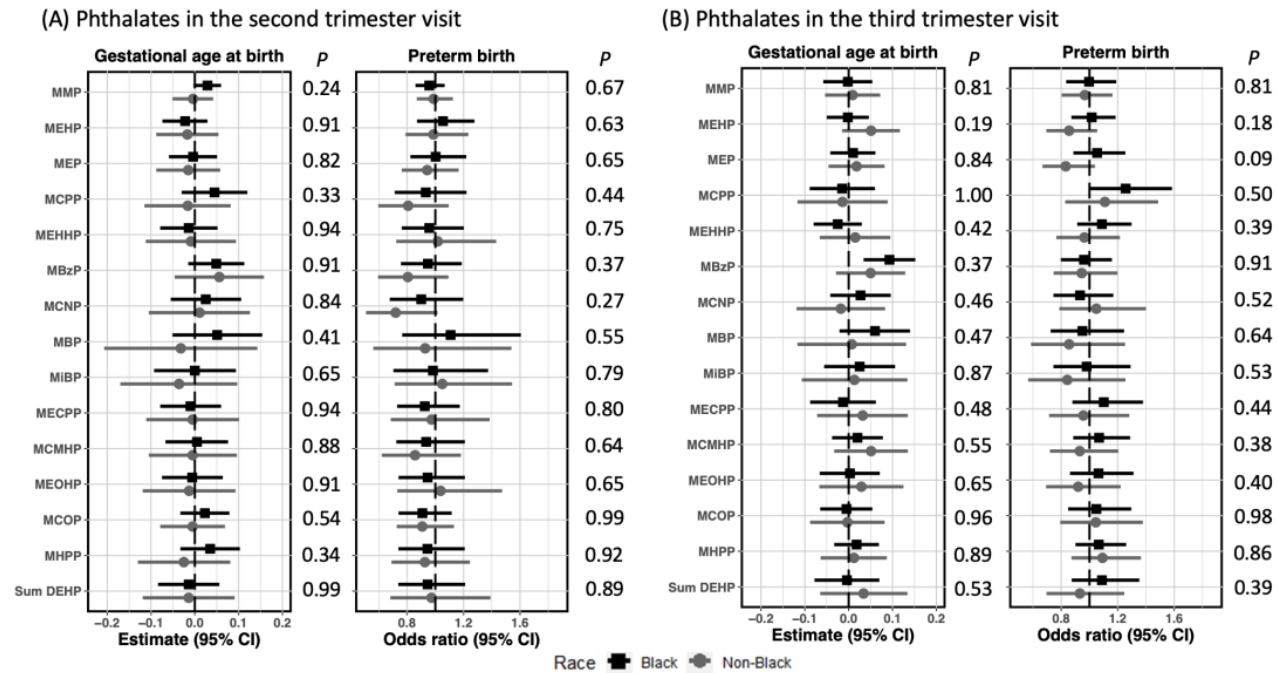
Figure A1. Estimated associations between prenatal phthalates and birth outcomes from the fully adjusted models, stratified by maternal race. The interaction models were adjusted for maternal age at delivery, maternal education (high school and less vs. above high school), income adjusted for house- hold size, marital status (Married vs. Widowed/Divorced/Separated/Never married vs. Living with partner), insurance coverage (No insurance/Medicare or Medicaid Only vs. Medicare/Medicaid + Private/Private only), SG adjusted urinary cotinine measurements in the second trimester, medical history of preterm birth (Yes vs. No), pre-pregnancy body mass index (BMI) class (Under vs. normal vs. overweight vs. obesity), parity (0 vs. 1/2 vs. >=3), and the interaction term between maternal race (Black vs. non-Black) and individual phthalates. The estimates were obtained from the models with continuous gestational age, and were interpreted as two-fold increase for each individual phthalate. The odds ratio was interpreted as two-fold increase for each individual phthalate. The p value is for the interaction